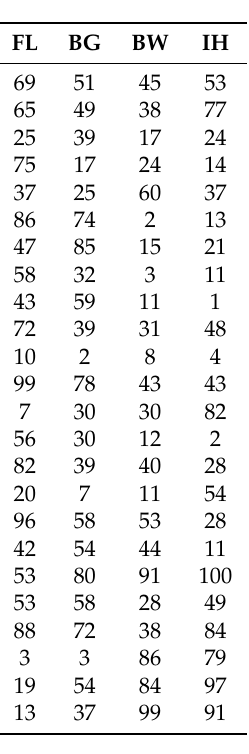
Table 2. Percentile profiles of outliers of foot shape variables for